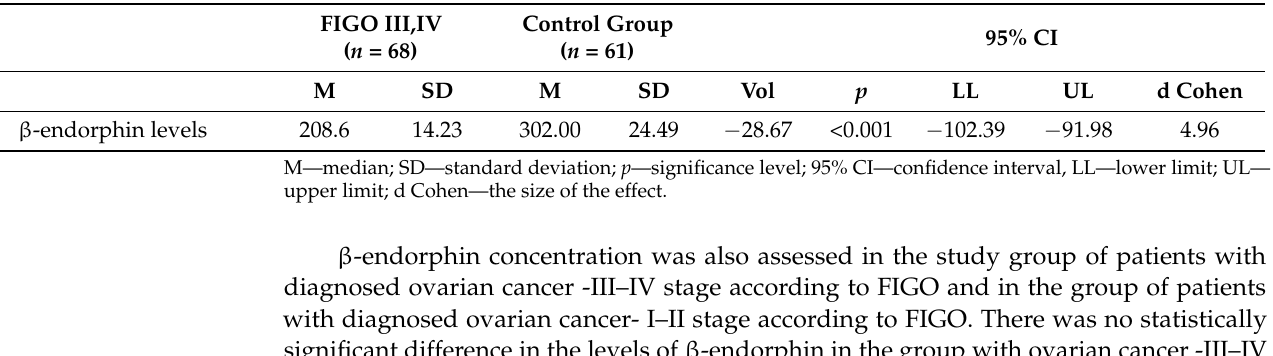
Table 3. The preoperative levels of β -endorphin in the study group (with ovarian cancer—III–IV stage according to FIGO) and the control group (with benign neoplastic lesions and simple ovarian cysts).